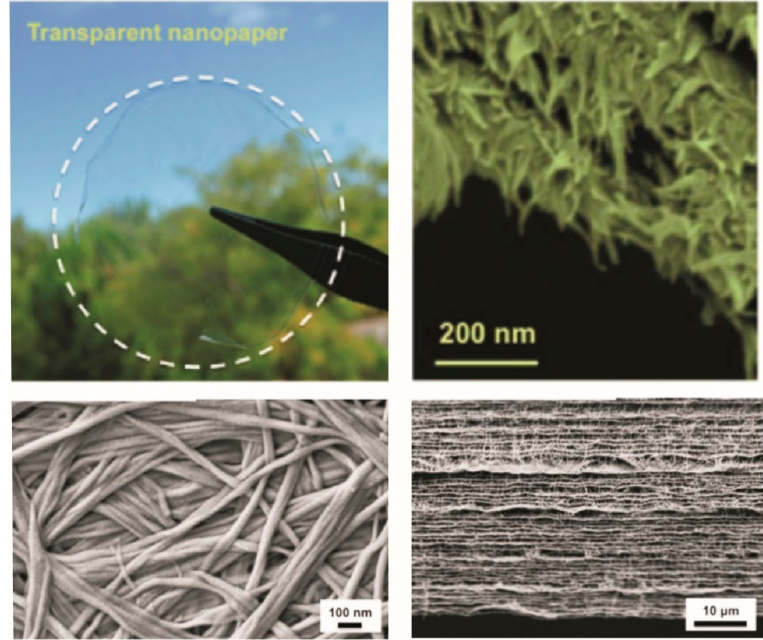
Figure 1. Photograph of nanocrystalline cellulose membrane and corresponding scanning electron microscopy (SEM) micrograph. The SEM image of the bacterial cellulose surface (bottom images) ob- tained from the direct drying process and corresponding cross-section. Reproduced with permission of Elsevier